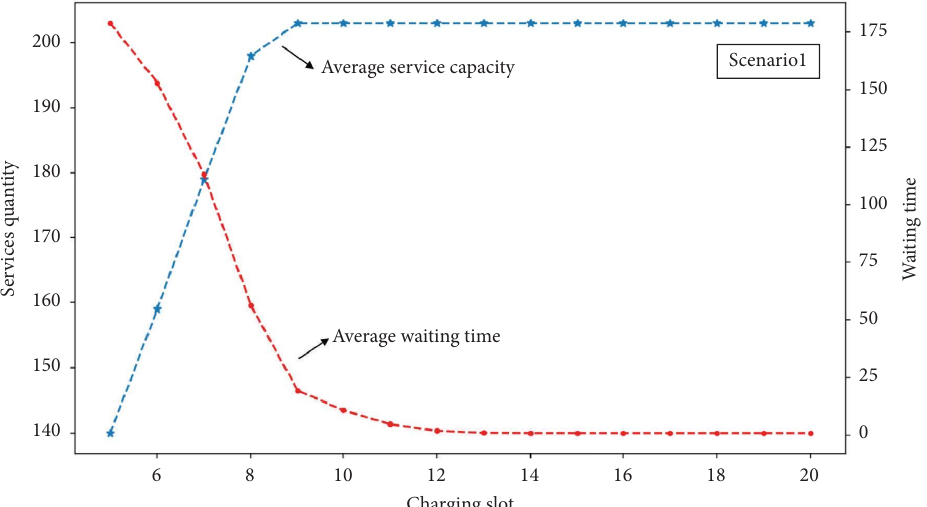
Figure 25: Simulation results of scenario